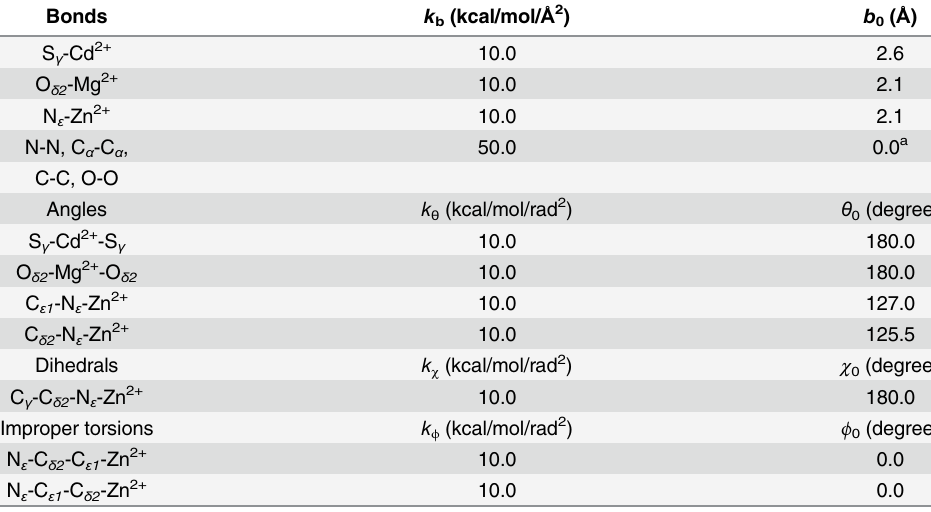
Table 2. Force field parameters for the metal ion